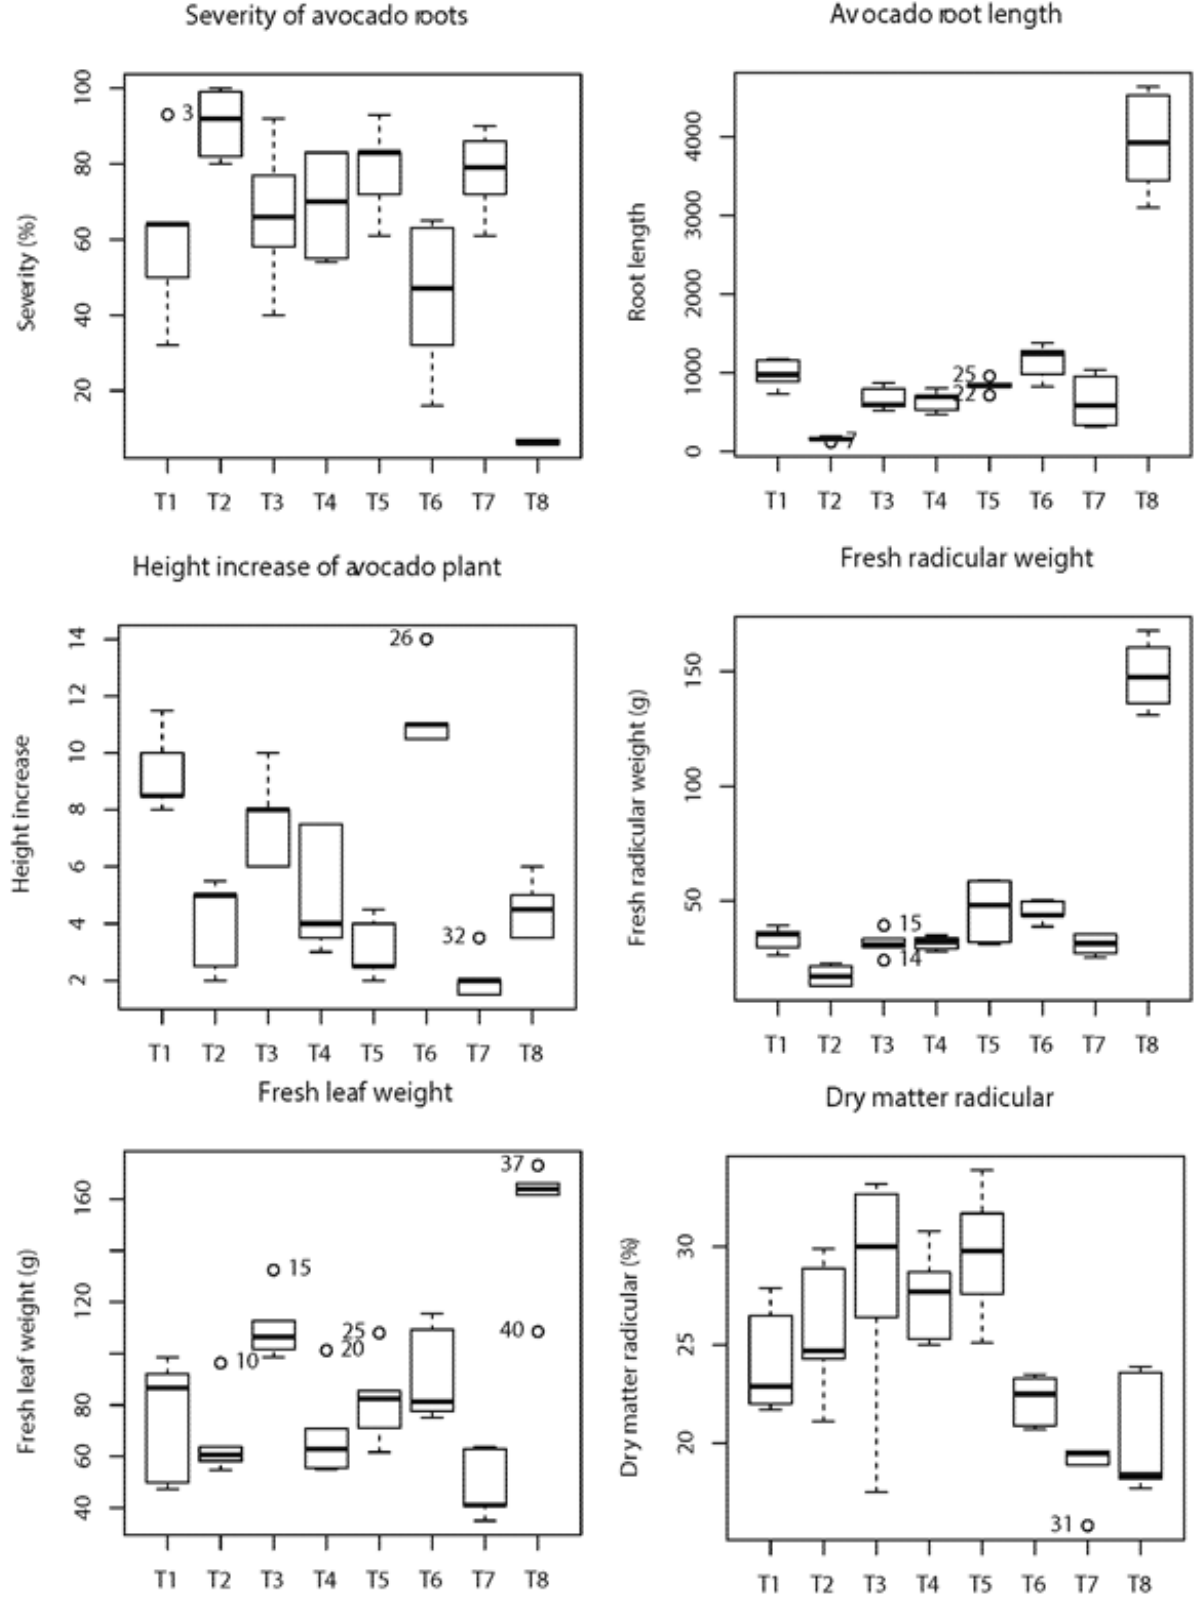
Fig. 2. Measurement of severity of avocado roots (%), avocado root length, height increase of avocado plant (cm), fresh radicular weight (g), fresh leaf weight (g) and dry matter radicular (%) of treatments inoculated with strains Pseudomonas spp. against P. cinnamomi, under greenhouse